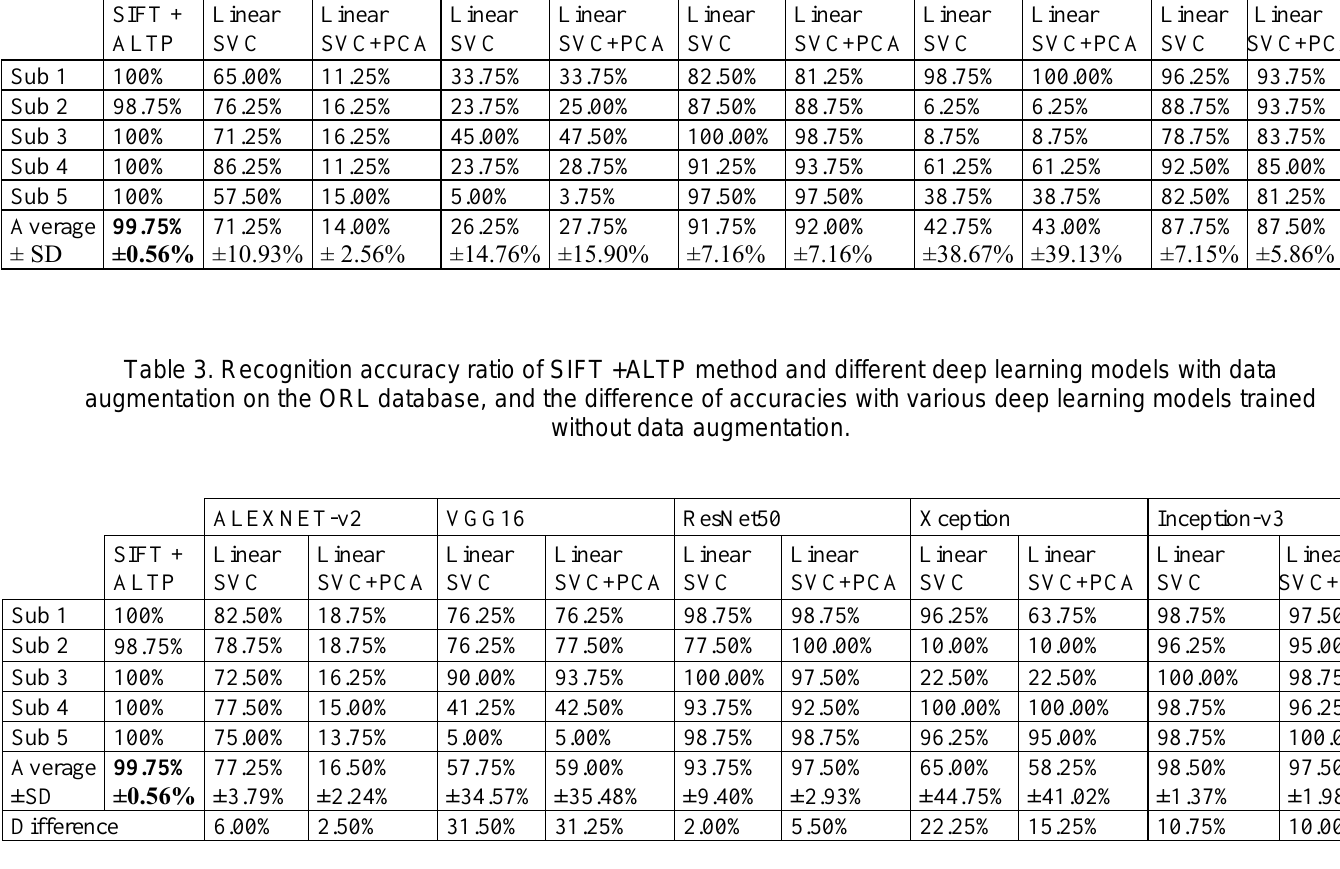
Table 4. recognition accuracy ratio of SIFT + ALTP method and different deep learning models with transfer learning on the ORL database, and the difference of accuracies with various deep learning models trained with data